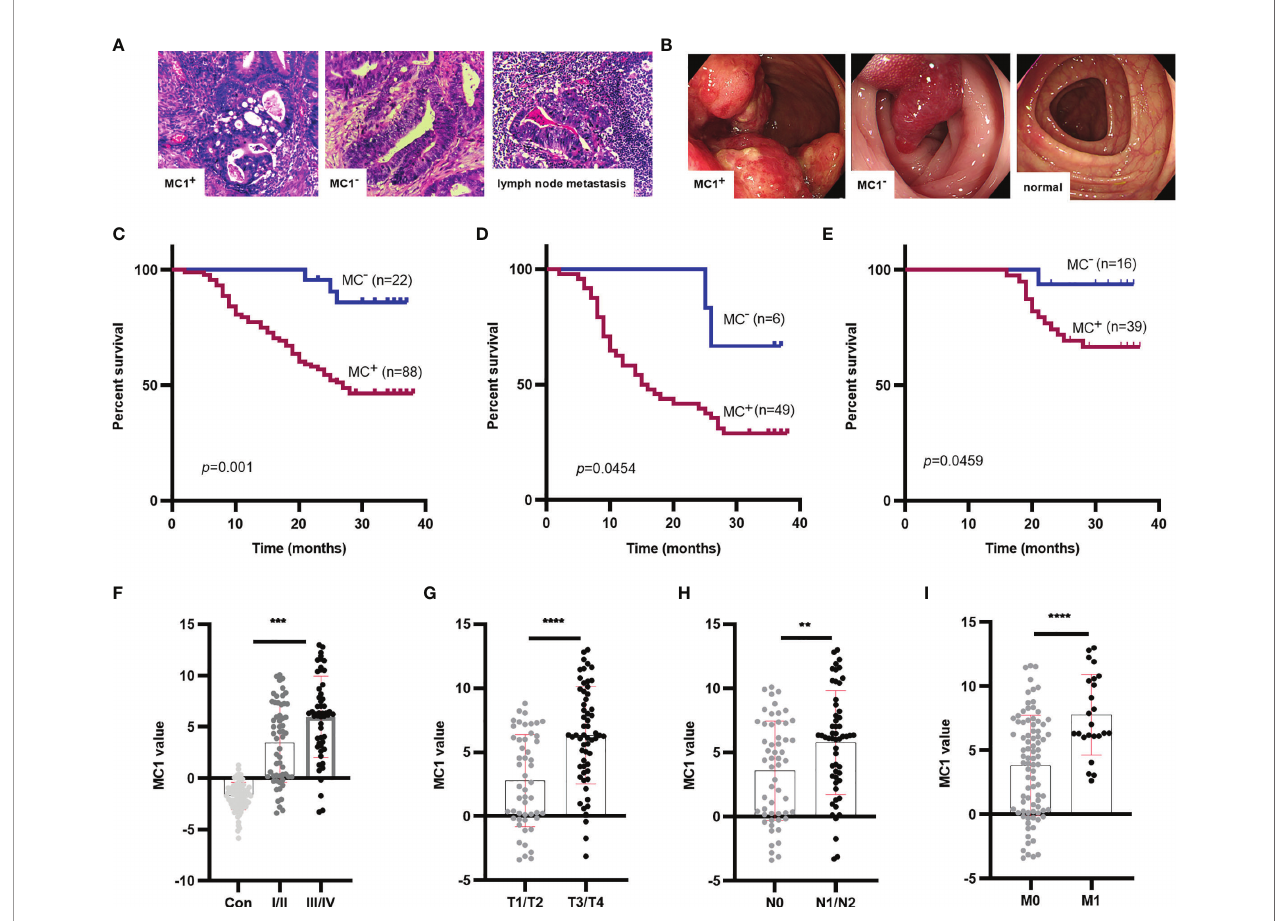
FIGURE 6 | Survival analysis for MC1 values in CRC patients, and MC1 values in different T, N, M stage of CRC. (A) The typical pathological data for patients who were MC1 + , MC1 - , or suffering lymph node metastasis. (B) The colonoscopy data from patients who were MC1 + , MC1 - , or colonoscopy from healthy individuals. (C) Log-rank survival analysis showed that MC1 + was associated with poor prognosis in CRC patients. To determine whether the role of MC1 in predicting survival in patients with CRC is related to tumor progression, the prognostic role of MC1 in early CRC (I/II stage) and advanced CRC (III/IV stage) was evaluated. (D, E) : MC1 + is associated with poor prognosis of CRC in both early and advanced stage. (F) Serum MC1 values in healthy individuals and CRC patients at stage I/II or III/IV. Serum MC1 values in different (G) T stage (T1/T2: the tumor did not penetrate the muscularis propria; T3/T4: the tumor penetrated the muscularis propria to the subserosal, visceral layer of peritoneum or directly invaded or adhered to other organs or structures), (H) N stage (N0: no lymph node metastasis; N1/N2: at least one lymph node metastasis), (I) M stage (M0: no distant organ metastasis; M1: with distant organ metastasis). **** p ≤ 0.0001, *** p ≤ 0.001, ** p ≤